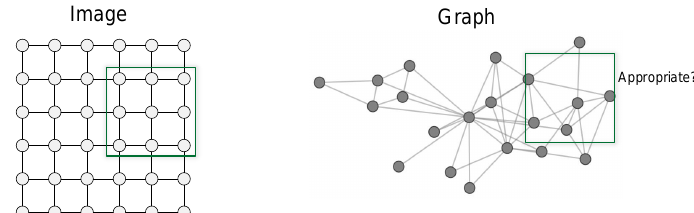
Figure 3. In the practice of classic deep learning, it is reasonable and effective to apply sliding window on images. However, there is no fixed notion of locality on graph, and we cannot apply sliding window on the graph